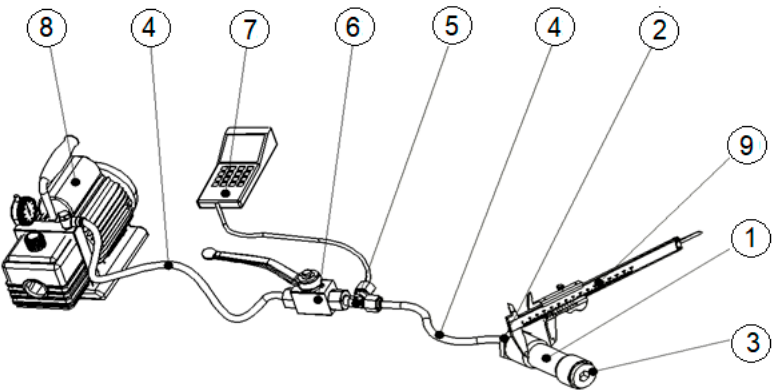
Figure 2. The experimental setup: 1: sample; 2: joint hex-nipple M118x1.5; 3: metallic cork with gasket;